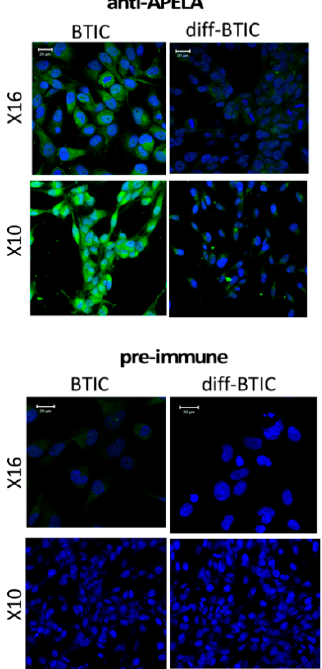
Figure 2. Immunohistochemistry (IHC) for APELA protein expression in BTICs and differentiated BTICs. IHC was performed on bulk differentiated and X10 and X16 BTICs. Staining was performed with APELA antisera or pre-immune sera and processed for IHC. Nuclei were counterstained with 4’,6-Diamidine-2’-phenylindole dihydrochloride (DAPI). Note, the markedly more intense cytoplasmic staining for APELA in BTICs than in bulk GBM cells, and no detectable staining obtained with pre-immune sera. Representative images are shown. Staining with pre-immune sera showed no IHC staining.